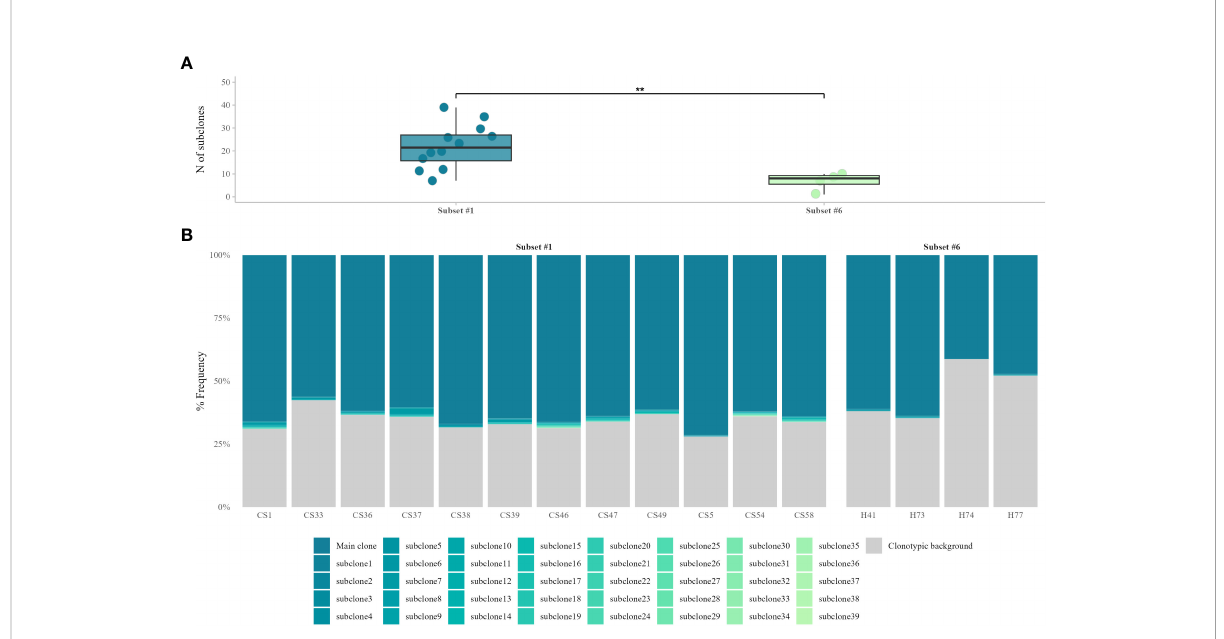
FIGURE 1 VH CDR3-derived, subclonal heterogeneity in ‘ truly unmutated ’ BcR IG rearrangements. (A) Comparison of subclonal branching of the VH CDR3 between the two stereotyped subsets shows signi fi cant differences (p = 0.005) in the number of subclonal variants, with subset #1 displaying higher VH CDR3 intraclonal variability. (B) Contribution of ‘ truly unmutated ’ IGHV-IGHD-IGHJ rearrangements to the total repertoire, for stereotyped subsets #1 and #6. The main CLL clonotype and its respective CLL-related, ‘ truly unmutated ’ subclonal variants are depicted in different shades of blue. The clonotypic background consists of either sequences bearing SHM in the rearranged IGHV gene, subclonal variants with very small frequencies or CLL-unrelated rearrangements. **,